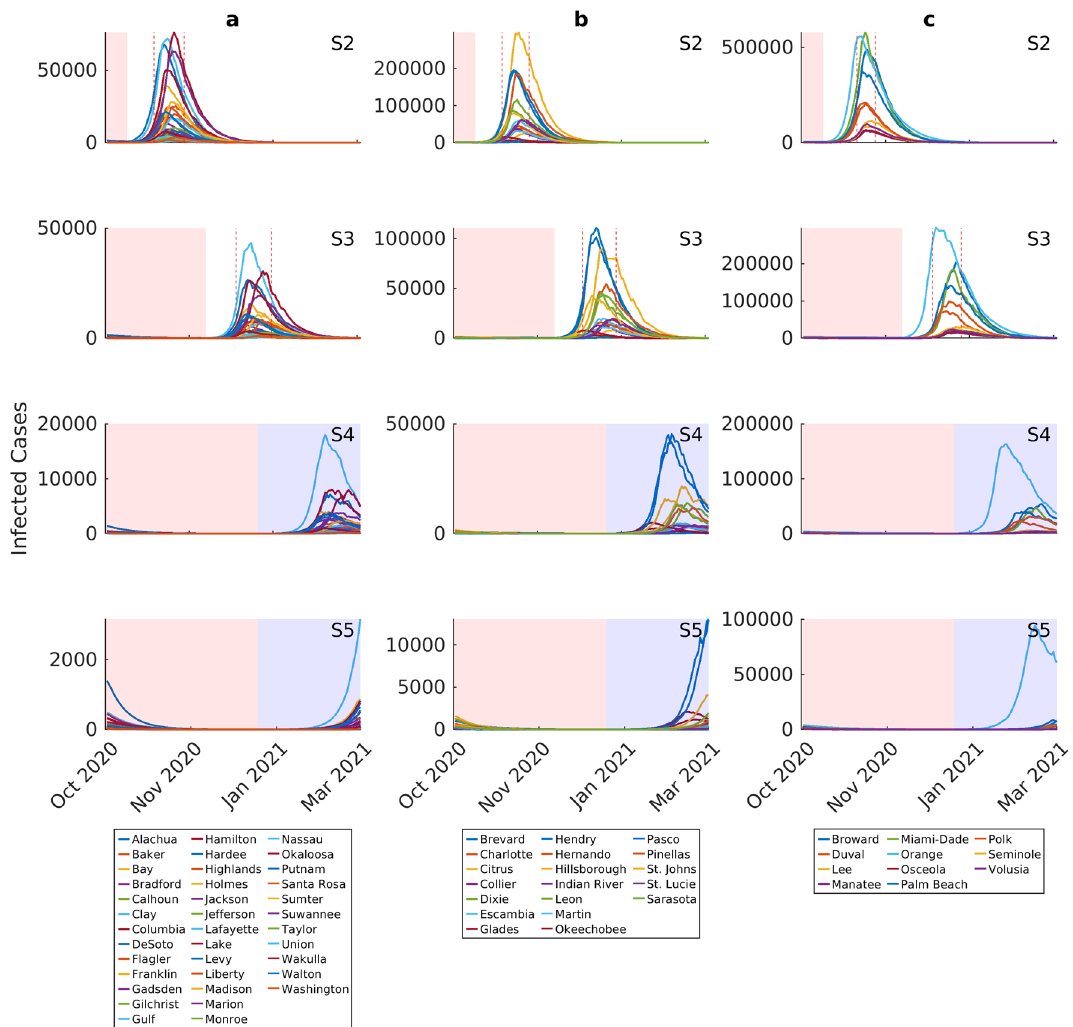
Figure 3. Epidemic forecasts for individual counties under four different social intervention scenarios. Note the differences in y-axis values when comparing scenarios. Each curve represents the median prediction for a given county. The results are stratified by initial incidence growth rates observed in each county (Group b < 0.05, Group b > 0.05–0.15, Group c > 0.15). The intervention scenarios are as follows (also see Supplementary Fig. S2): S2: maintain movement estimate and social distancing measures over 2 weeks from October 1st to October 14th; S3: maintain movement estimate and social distancing measures over 8 weeks from October 1st to November 30th; S4: maintain movement estimate and social distancing measures through end December 2020 + begin low intensity contact tracing and quarantine efforts on October 1st through March 2021; S5: maintain movement estimate and social distancing measures through end December 2020 + begin high intensity contact tracing and quarantine efforts on October 1st through March 2021. The red shading in each plot indicates the duration of movement and social distancing in each scenario, while the blue shading shows quarantining measures without movement restrictions or social distancing. The range of 2nd wave infection peaks for each county group is shown by dotted vertical lines. For scenario 2, the peak of infected cases occurs between October 29th– November 16th for Group a, October 29th–November 14th for group b, and November 2nd–November 13th for Group c. For scenario 3, the peak of infected cases occurs between December 17th–January 7th 2021 for Group a, December 16th–January 5th 2021 for group b, and December 17th–January 3rd 2021 for Group c. Epidemic ending dates for scenario 2 occur between January 2nd–February 17th 2021 for Group a, January 6th–February 21th 2021 for group b, and February 11th–February 27th, 2021 for Group c, respectively. For scenario 3, the corresponding end dates were between February 20th–March 2nd 2021 for Group a, and between February 22nd to beyond March 2nd for Groups b and